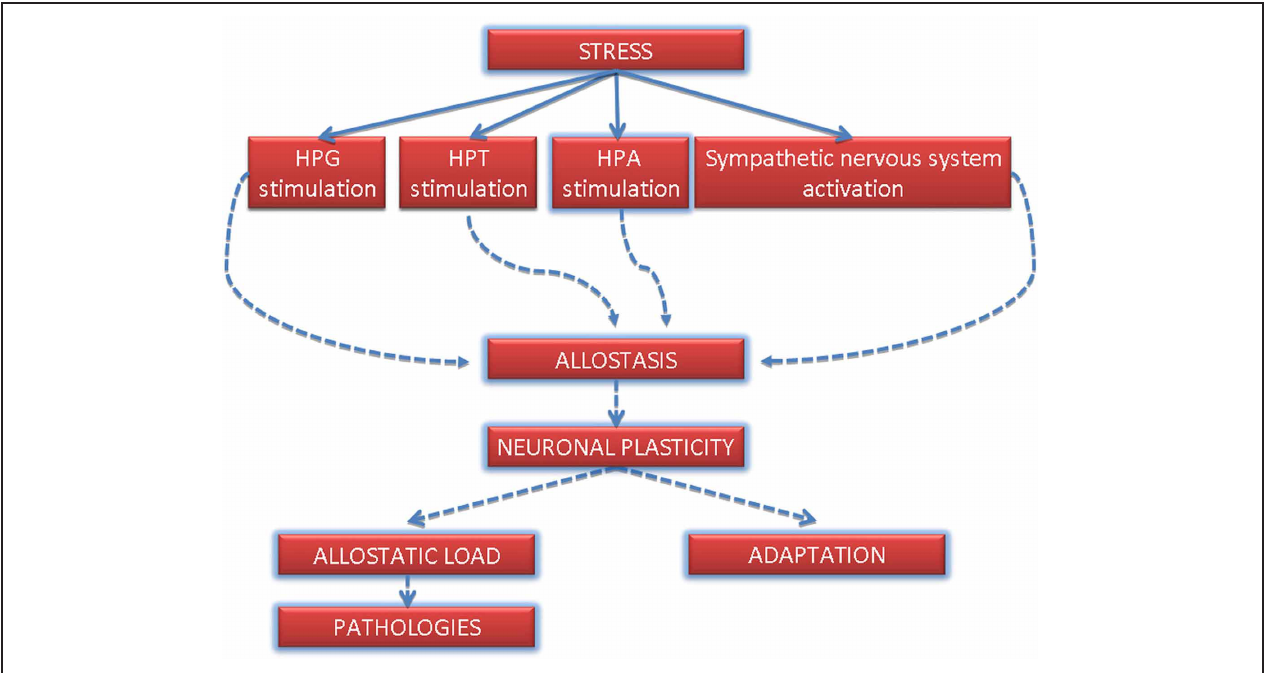
FIGURE 2 | Most representative stress-induced pathways and hypothetical involvement in the induction of allostatic load. HPT, hypothalamus-pituitary-thyroid axis; HPG, hypothalamus-pituitary-gonadal axis; HPA, hypothalamus-pituitary-adrenal